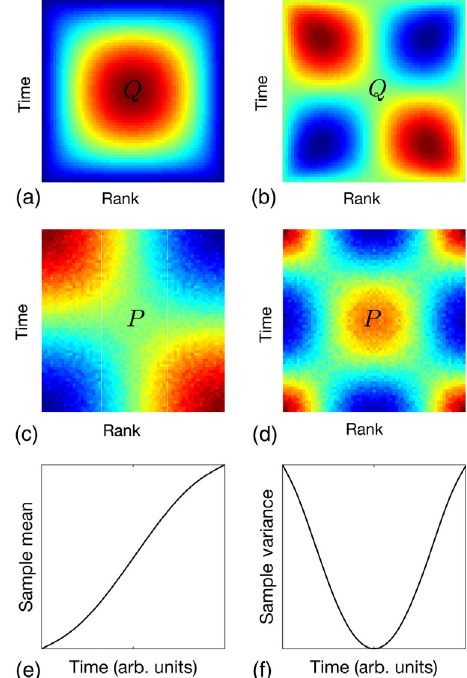
FIG. 7. Examples of modes 1 and 6: (a) ψ 1 with D 4 symmetry; (b) ψ 6 with R 2 symmetry [both from Fig. 6(a)]; (c) inverting ψ 1 for P 1 from Eq. (1), which gives a result with R 2 symmetry; (d) same procedure for P 6 with D 4 symmetry. Similarly, panel (e) shows the conditionally averaged sample mean of the data for ψ n 1 (averaged over t trials) and resembles the Lugano temper- ature time series of Sec. II. In panel (f), the vaselike profile in sample variance, also from conditional sampling, represents overpopulation of the four corners of P 6 . [Both panels (e) and (f) are from Fig.